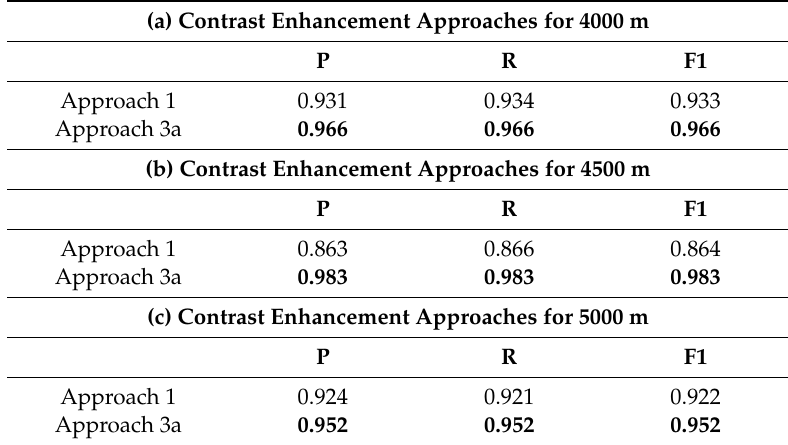
Table A2. Performance metrics for contrast-enhanced approaches within optical flow workflow for 4000–5000 m ranges. TV-L1 was used for optical flow